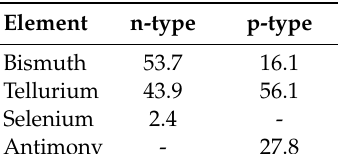
Table 6. Results of energy-dispersive X-ray spectroscopy (EDX) analysis, values in wt.%.